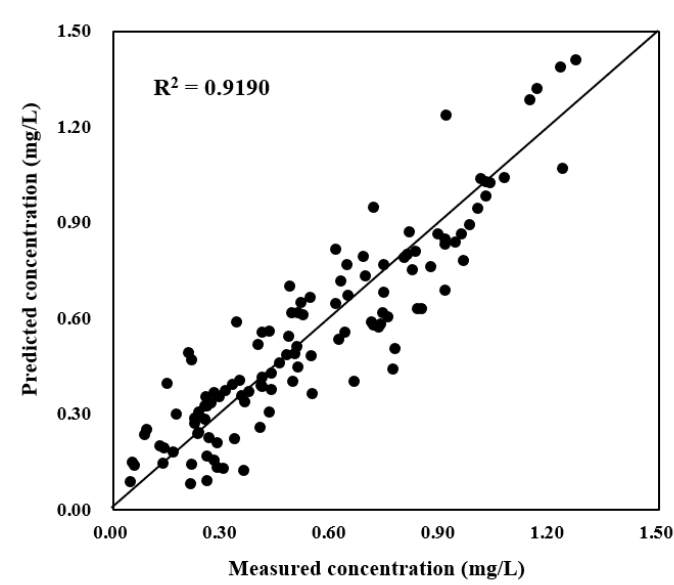
Figure 4. Correlation between model and experimental data in the chlorine kinetics using seawater.